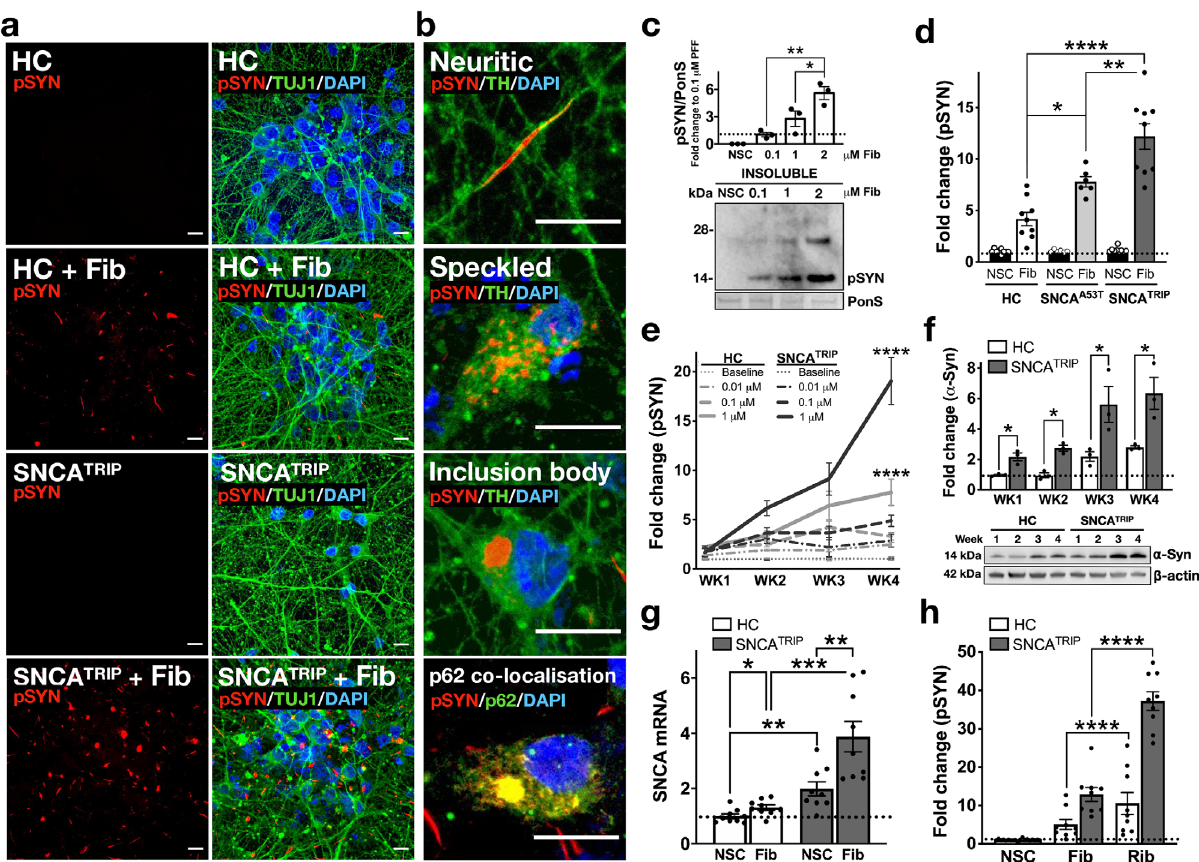
Fig. 1 Characterisation of α -synuclein seeded aggregation in iPSC-derived dopaminergic neurons. a Addition of exogenous α -Syn fi brils ( + Fib) seeded the aggregation of endogenous α -Syn as evident by pSYN immunoreactivity in red. Images are representative of three independent differentiations (scale bar: 10 µ m). b pSYN-positive aggregates were localised in axons (neuritic) or soma (speckled or Inclusion body) and co-localised with p62. Images are representative of three independent differentiations (scale bar: 10 µ m). c RIPA-insoluble fractions from seeded neuronal lysates were immunoreactive for pSYN by immunoblotting ( n = 3). d Dopaminergic neurons harbouring either the missense A53T mutation (SNCA A53T ) or SNCA gene triplication (SNCA TRIP ) had increased levels of pSYN compared to healthy controls 2 weeks post seeding, with SNCA TRIP neurons exhibiting the highest burden of seeded aggregates as quanti fi ed by HTRF ( n = 9 for HC, n = 9 for SNCA TRIP , n = 6 for SNCA A53T ). e A single exposure to fi brils on DIV45 at an increasing dose (baseline, 0.01, 0.1, 1 µ M) induced a dose and time-dependent increase in pSYN signal as quanti fi ed by HTRF ( n = 9 for SNCA TRIP and n = 5 for HC). f Endogenous α -Syn expression in neurons increased over time in culture. Increased baseline α -Syn expression by ~2.5-fold in SNCA TRIP neurons compared to controls as assessed by immunoblotting ( n = 3). g Upregulation of SNCA mRNA was triggered by fi bril treatment 2 weeks post seeding at DIV45. Induction of SNCA mRNA was more pronounced in SNCA TRIP compared to controls ( n = 9). h Ribbons exhibited higher seeding propensity than fi brils 4 weeks post seeding as evident by pSYN levels, quanti fi ed by HTRF ( n = 9). Each dot corresponds to one clone differentiated once and data are mean ± s.e.m from at least n = 3 differentiations per clone. * P < 0.05, ** P < 0.01, *** P < 0.001, **** P < 0.0001 by one-way ANOVA followed by Tukey ’ s multiple comparison test ( c , d , h ), two-way ANOVA followed by Tukey ’ s multiple comparison test ( e ), two-sided unpaired Student ’ s t test ( f , g ). Source data for c , d , e , f , g , h are provided as a Source Data fi